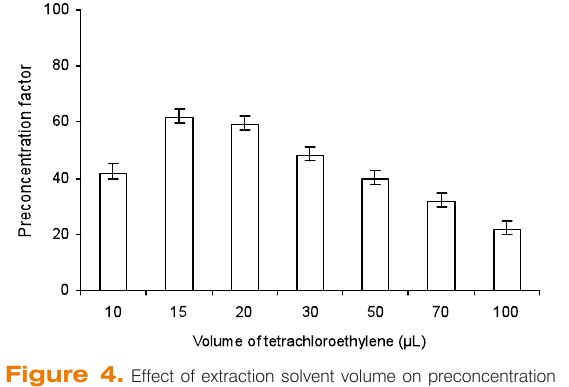
Figure 4. Effect of extraction solvent volume on preconcentration factor (analyte concentration 1 mg L -1 , volume of disperser solvent was 1 mL, pH = 3, n = 3).